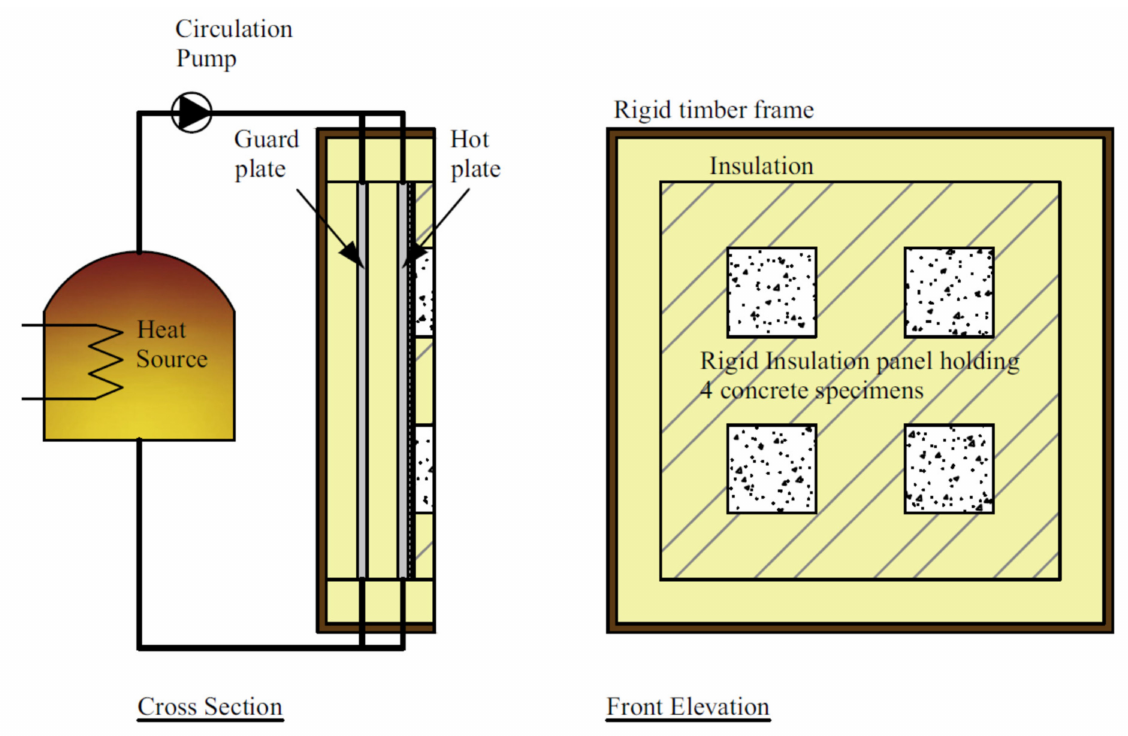
Figure 6. Concrete thermal conductivity test schematic [56]. Reprinted from Solar Energy, Parametric investigation of concrete solar collectors for façade integration, Richard O’Hegarty, Oliver Kinnane, Sarah J. McCormack, 153 , 396–413, Copyright 2017, with permission from